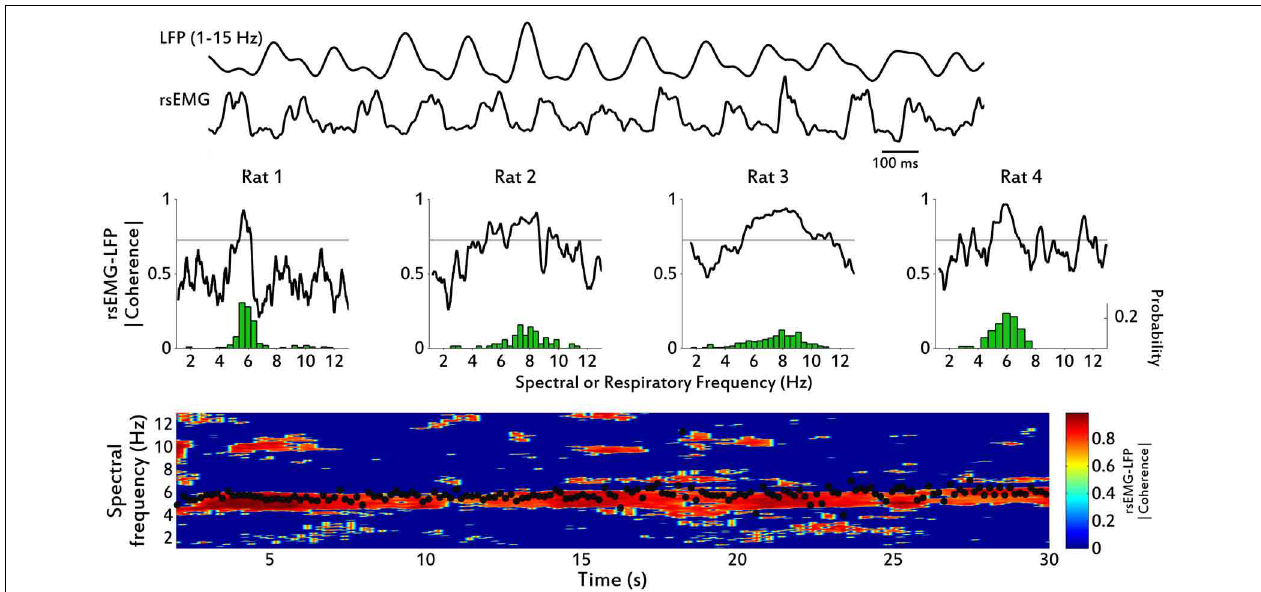
FIGURE 3 | Spectral coherence between diaphragm EMG and olfactory bulb LFP. Top: example traces of filtered (1–15Hz) OB LFP and rsEMG, from Rat 4. Middle: spectral coherence magnitude between rsEMG and low-pass filtered OB LFP for each of the four rats from which we collected both LFP and EMG signals. Dotted line marks the confidence level above which values are assumed to be significantly coherent. Note that coherent activity occurs